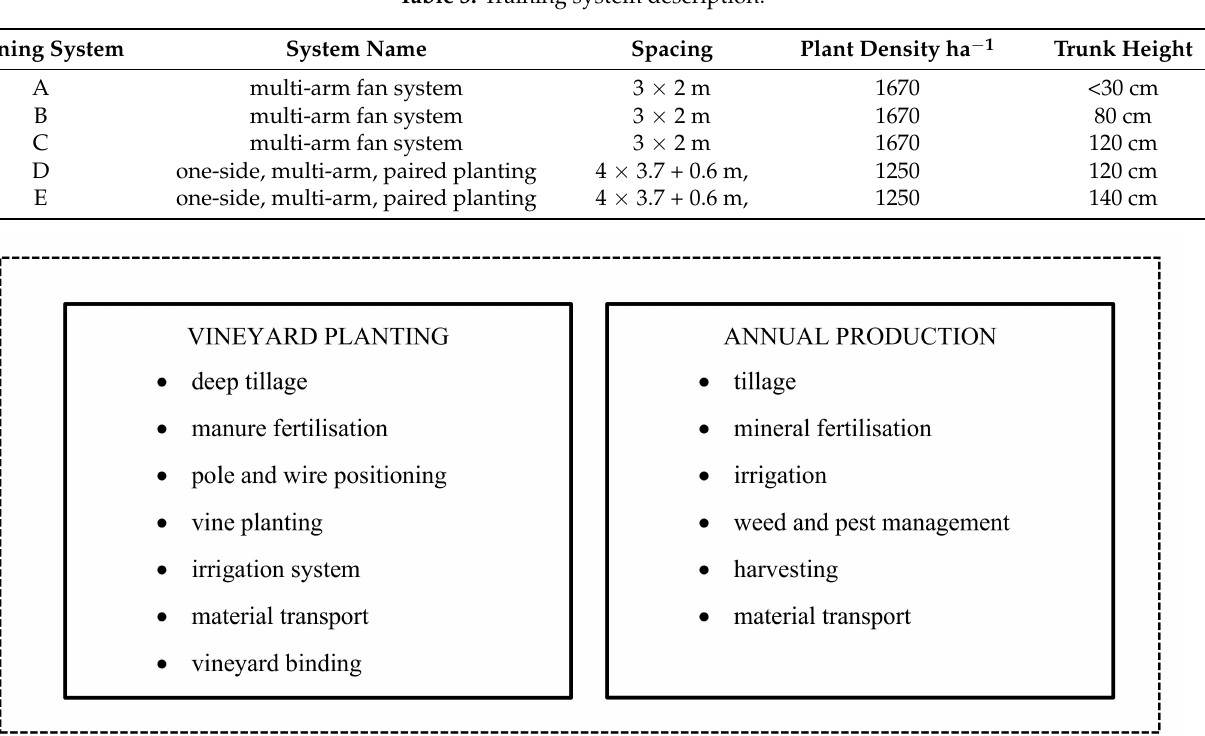
Figure 1. System